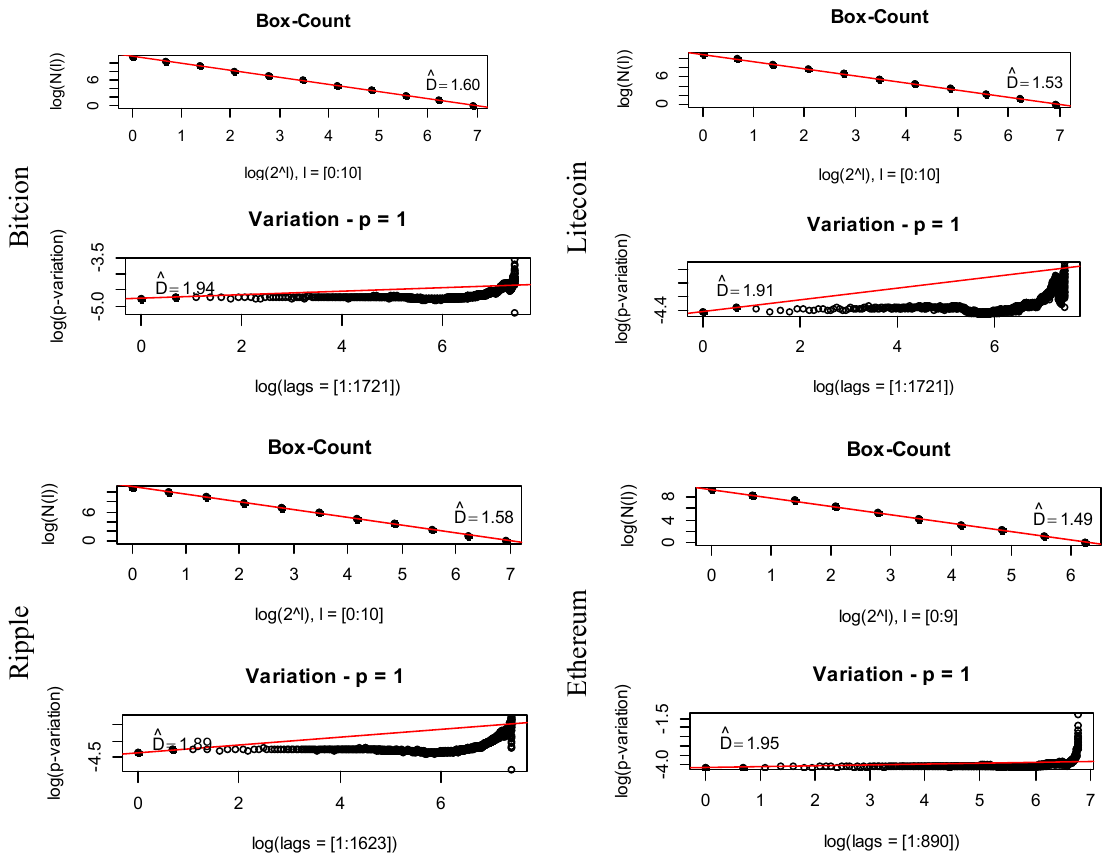
Figure 1. Fractal dimension graphics.